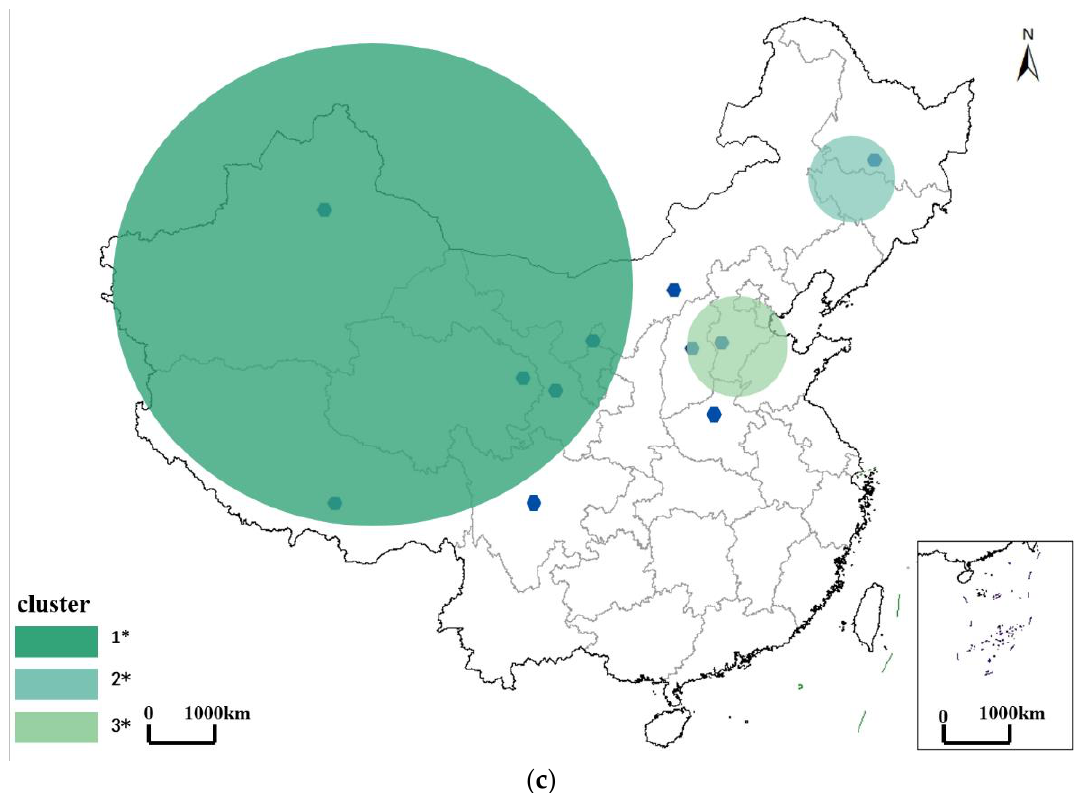
Figure 3. Spatiotemporal pattern of Brucellosis in: ( a ): outbreak period (2003 – 2014); ( b ) mild period (2014 – 2017); ( c ) recurrence period (2017 – 2019). * 1: most likely cluster; 2: the secondary cluster Ⅰ ; 3: the secondary cluster Ⅱ ; 4: the secondary cluster Ⅲ .